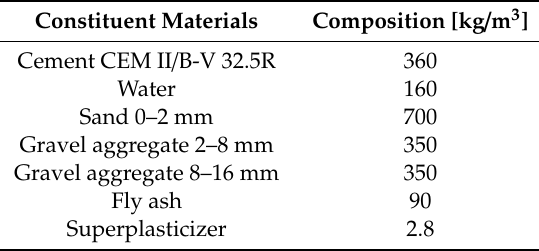
Table 1. Composition of the